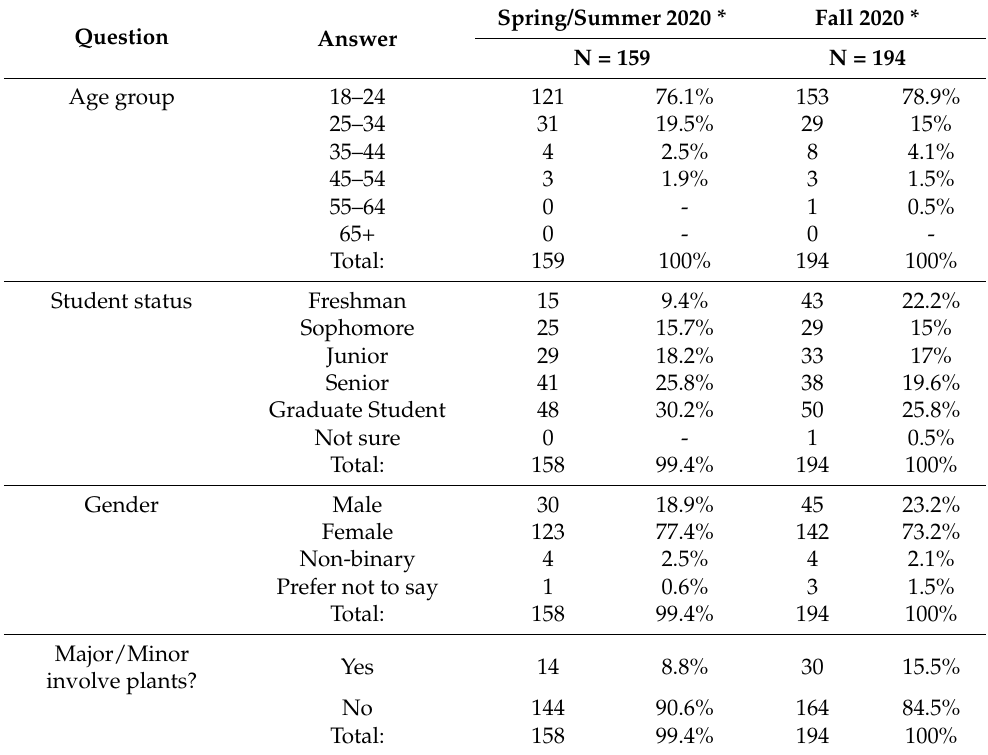
Table 1. Demographics of student respondents to the COVID-19 questionnaire in